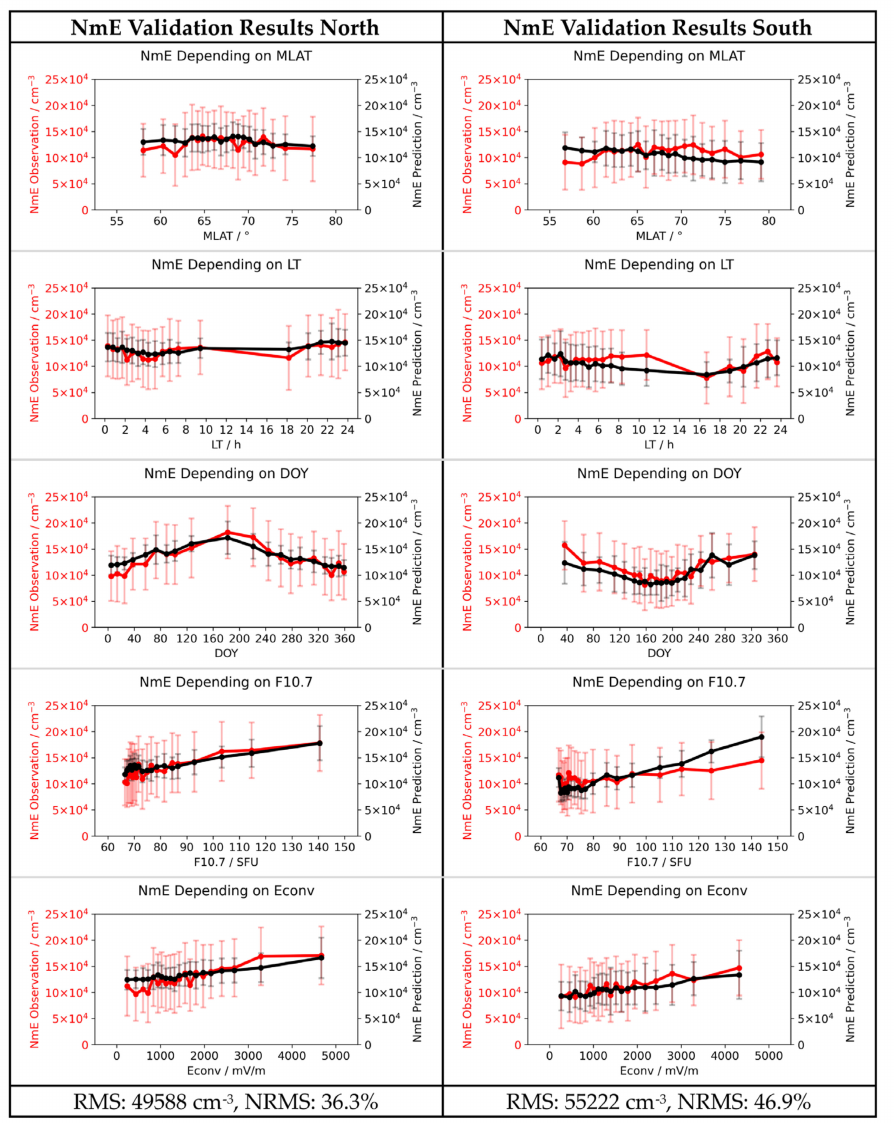
Figure 6. Observed (red) and predicted (black) NmE trends for the test dataset. ( Left ) Northern Hemi- sphere. ( Right ) Southern Hemisphere. Last row: RMS and NRMS deviation between observation and